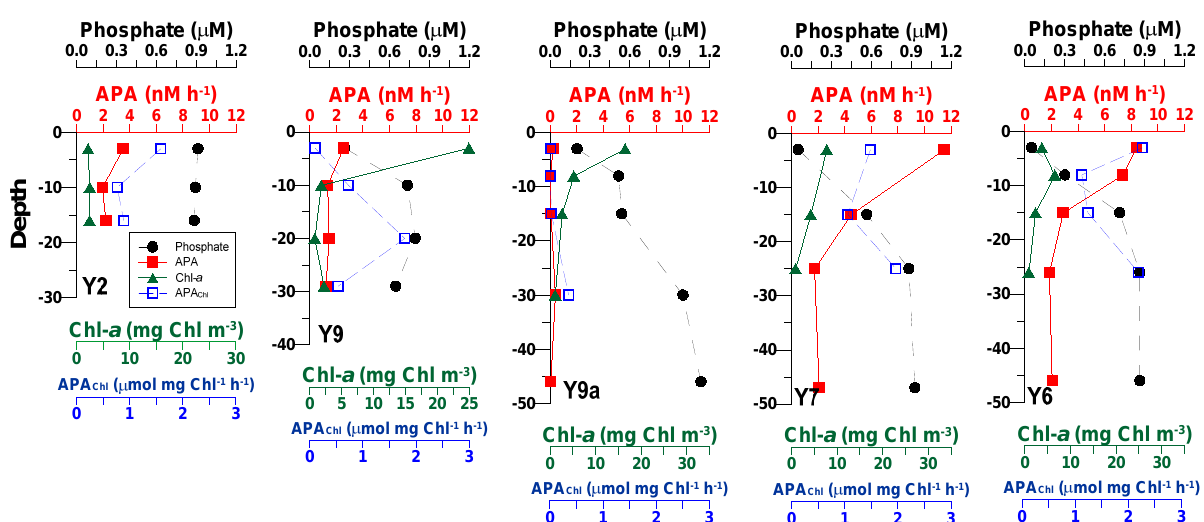
Fig. 6. Vertical profiles of phosphate, APA, Chl a , and APA Chl for stations along the CJ transect off the turbidity front.